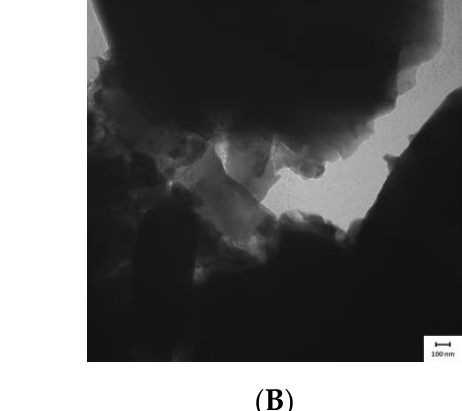
AlPO 4 treated at 400 ◦ C contained cavities, whereas Zn-AlPO 4 (Figure 7A,B), with high